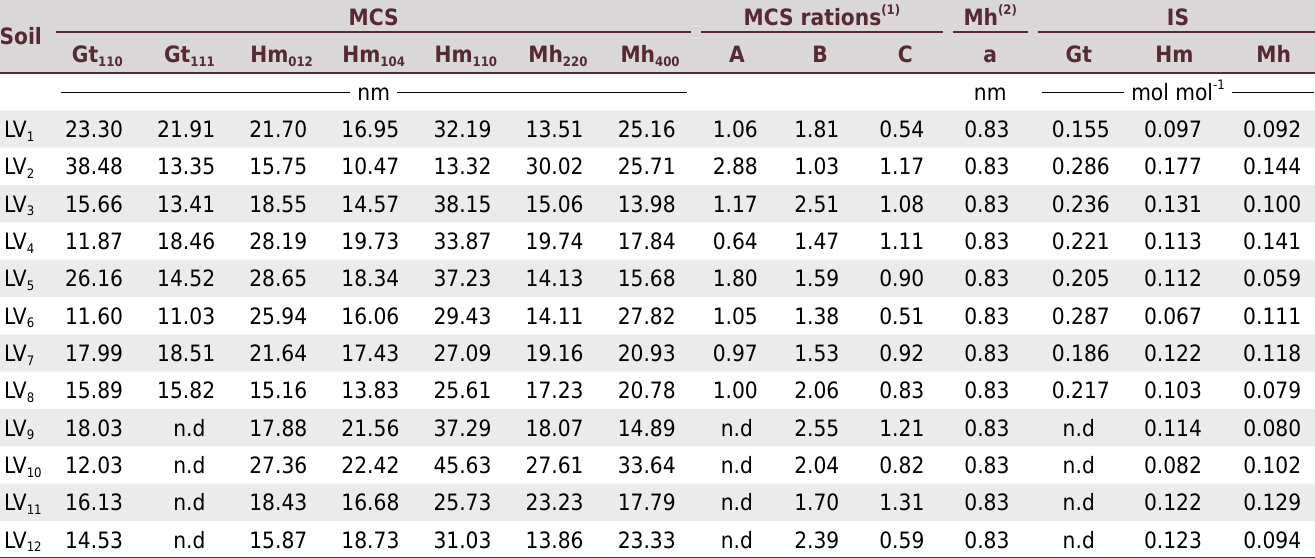
Table 2. Values of mean crystal size (MCS), MCS ratios, unit cell parameter (dimension a ) for maghemite (Mh), and isomorphic substitution of Fe by Al (IS) in goethite (Gt), hematite (Hm), and maghemite (Mh) Soil